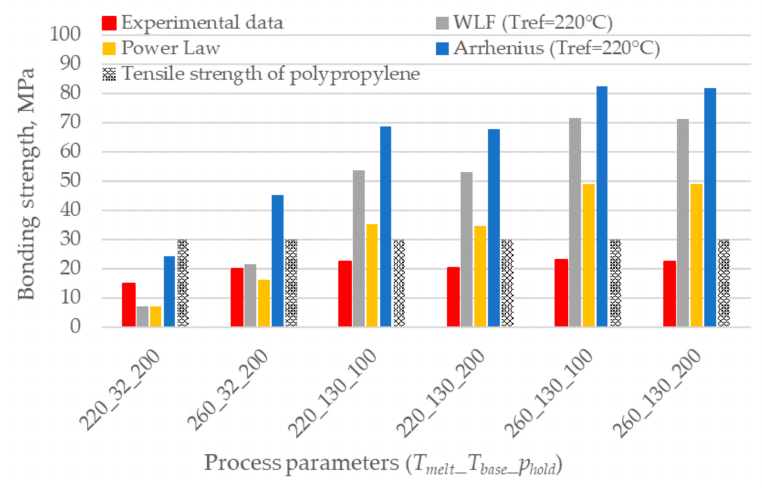
Figure 7. Comparison between the experimental bonding strength and the predictions based on the interface temperature evolution. The combination of process parameters is expressed using the code T melt _ T base _ p hold